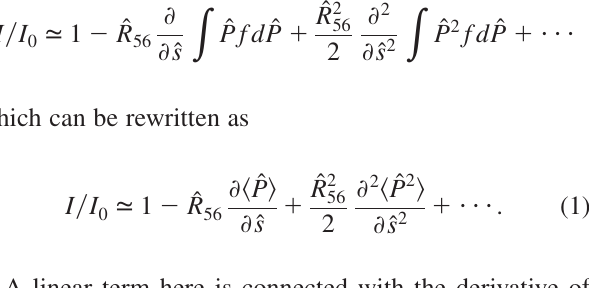
¼ 0 : 2 . The current profile T